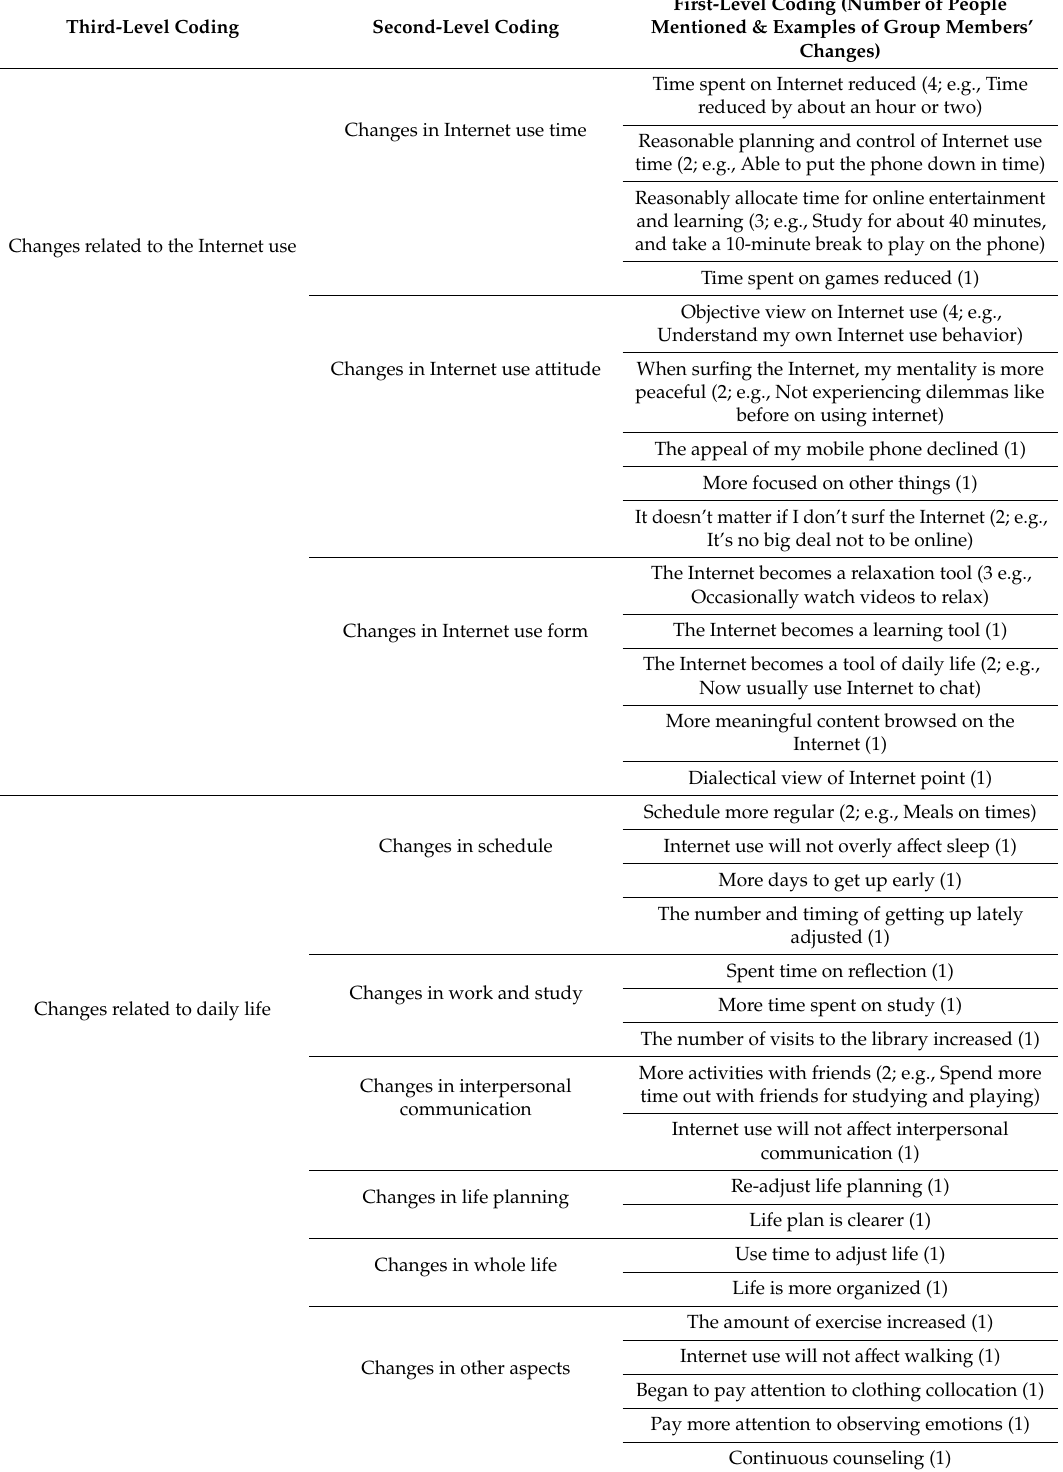
Table 5. Benign Changes after Group Counseling of Experimental Group